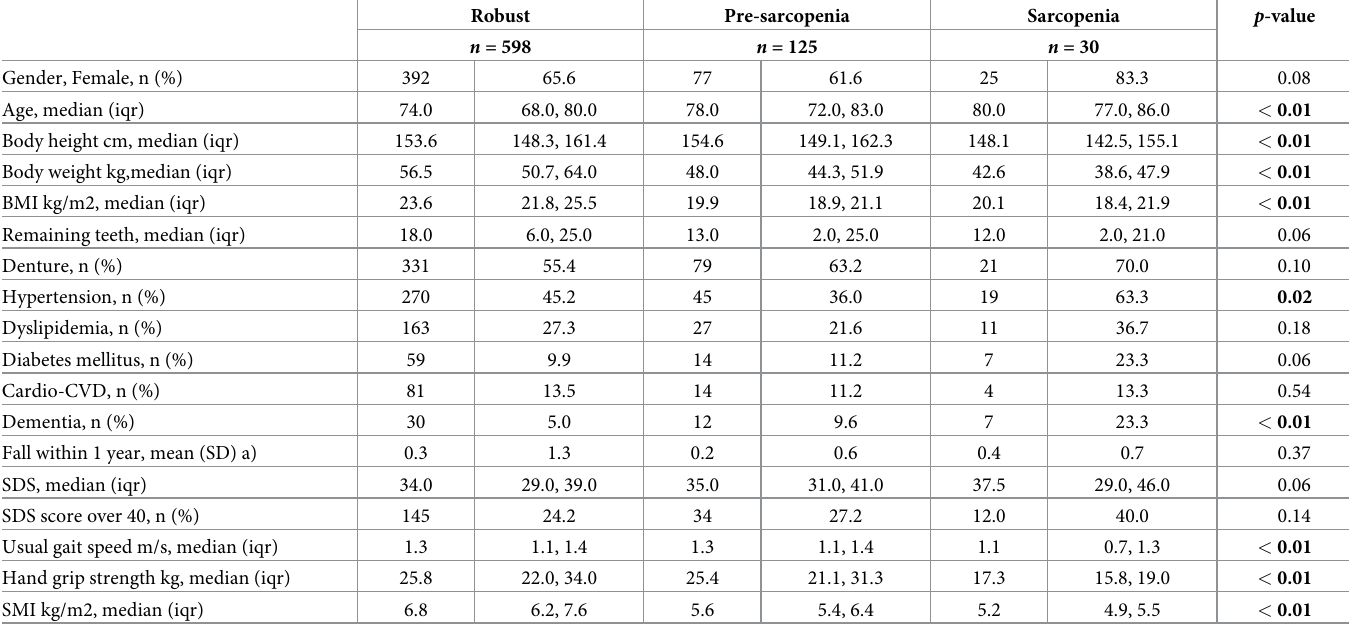
Table 1. Baseline characteristics of the study participants according to the presence of pre-sarcopenia and sarcopenia (n = 753). Robust